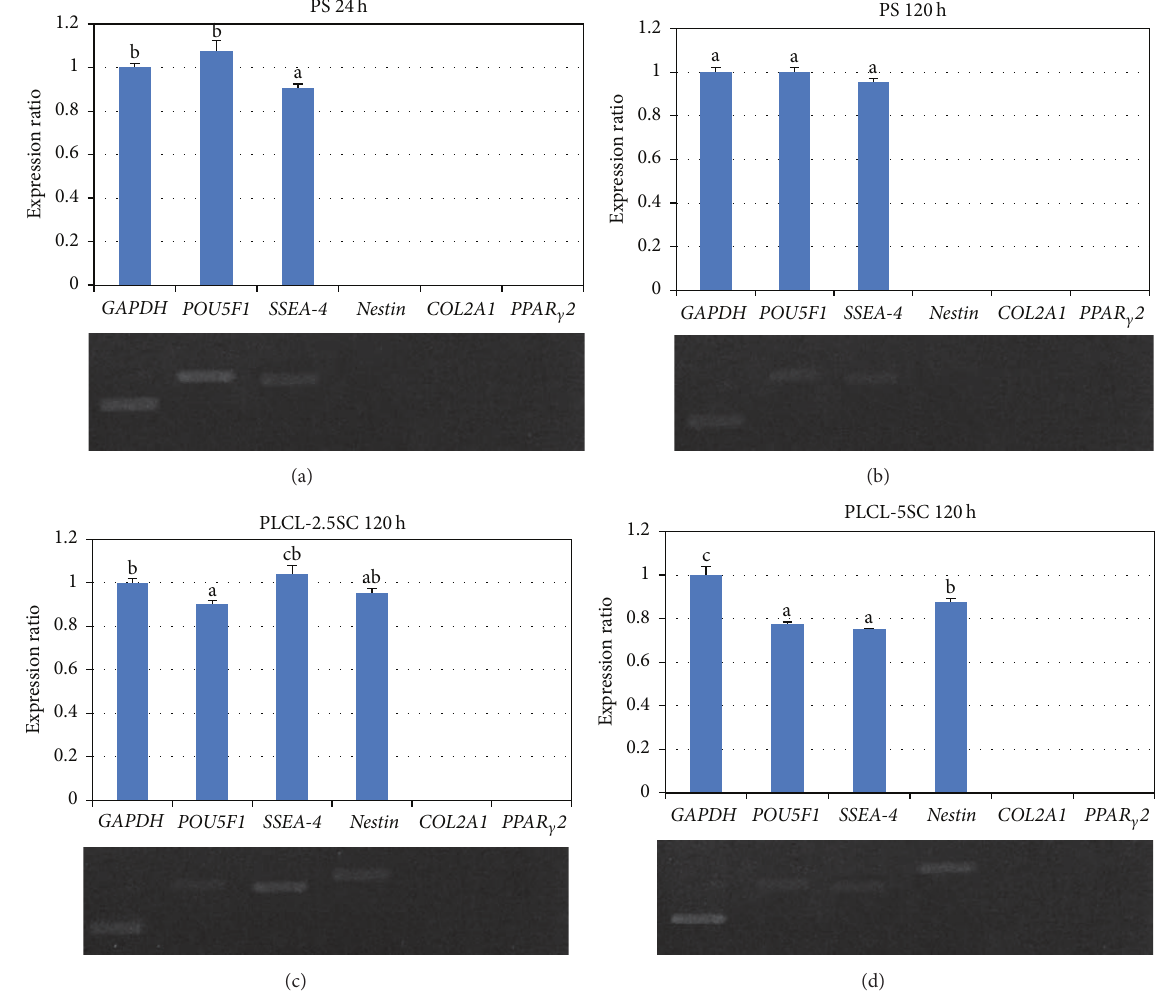
Figure 15: Gene expression of BCP-K1 cultured on PS (a) 24 hours, (b) PS 120 hours, (c) PLCL-2.5SC 120 hours, and (d) PLCL-5SC 120 hours. Statistical difference is indicated by lowercase letters (a, b, and c) ( 𝑝 ≤ 0.05